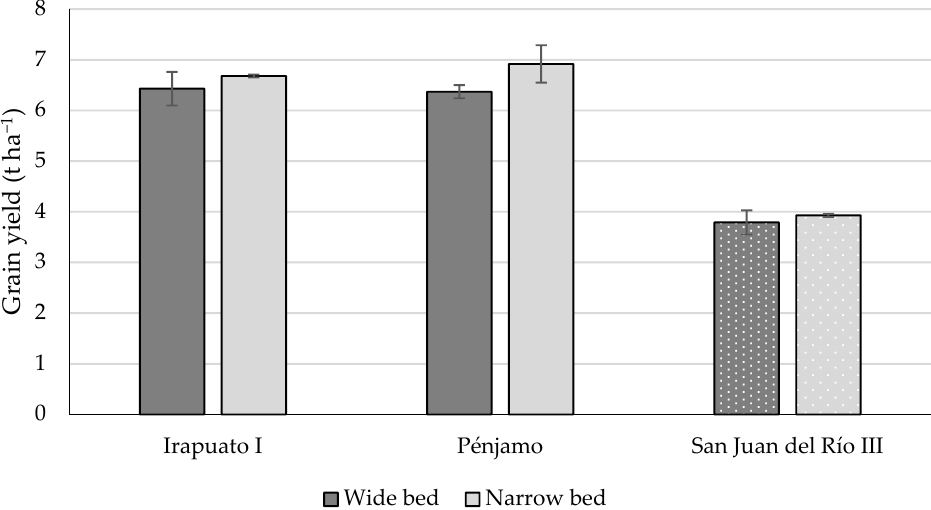
Figure 8. Wheat and barley yield, with planting in wide and narrow beds, under irrigated conditions in three sites in central Mexico. Average yield during the duration of the study; the error bars represent the standard deviation of the mean. Dotted bars indicate barley.